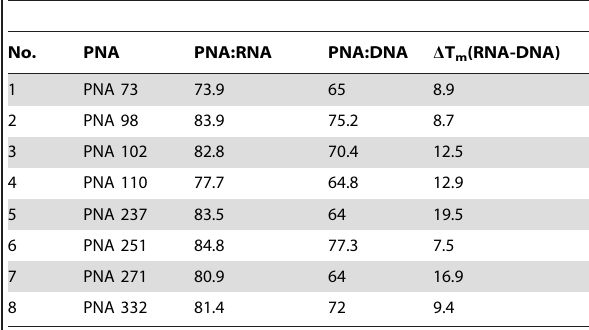
Table 2. UV Melting temperature ( u C) Value of PNA: RNA and PNA: DNA Duplexes*.